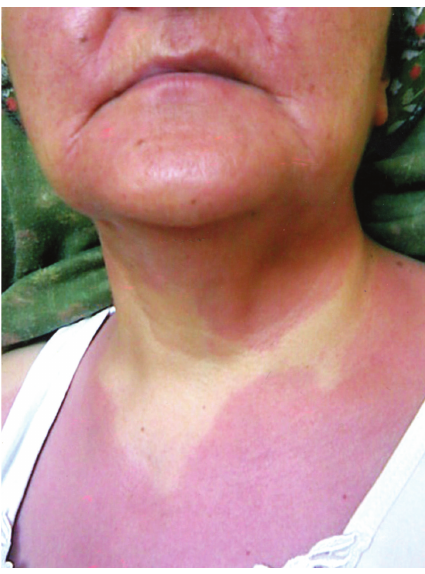
Figure 1: Flushing in face, neck, and upper chest with sharp mar- gins.